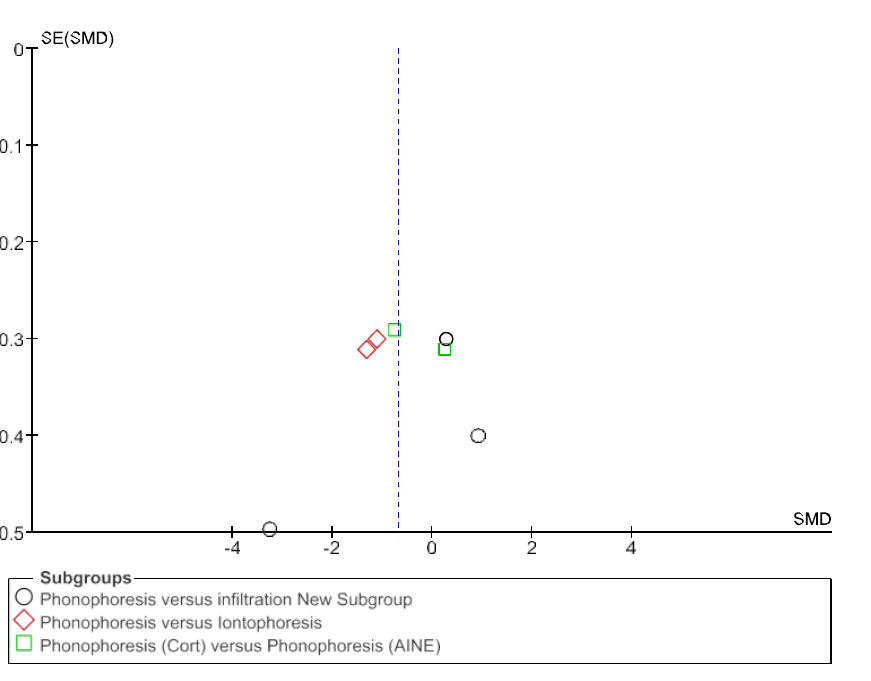
Figure 14. Phonophoresis for pain.